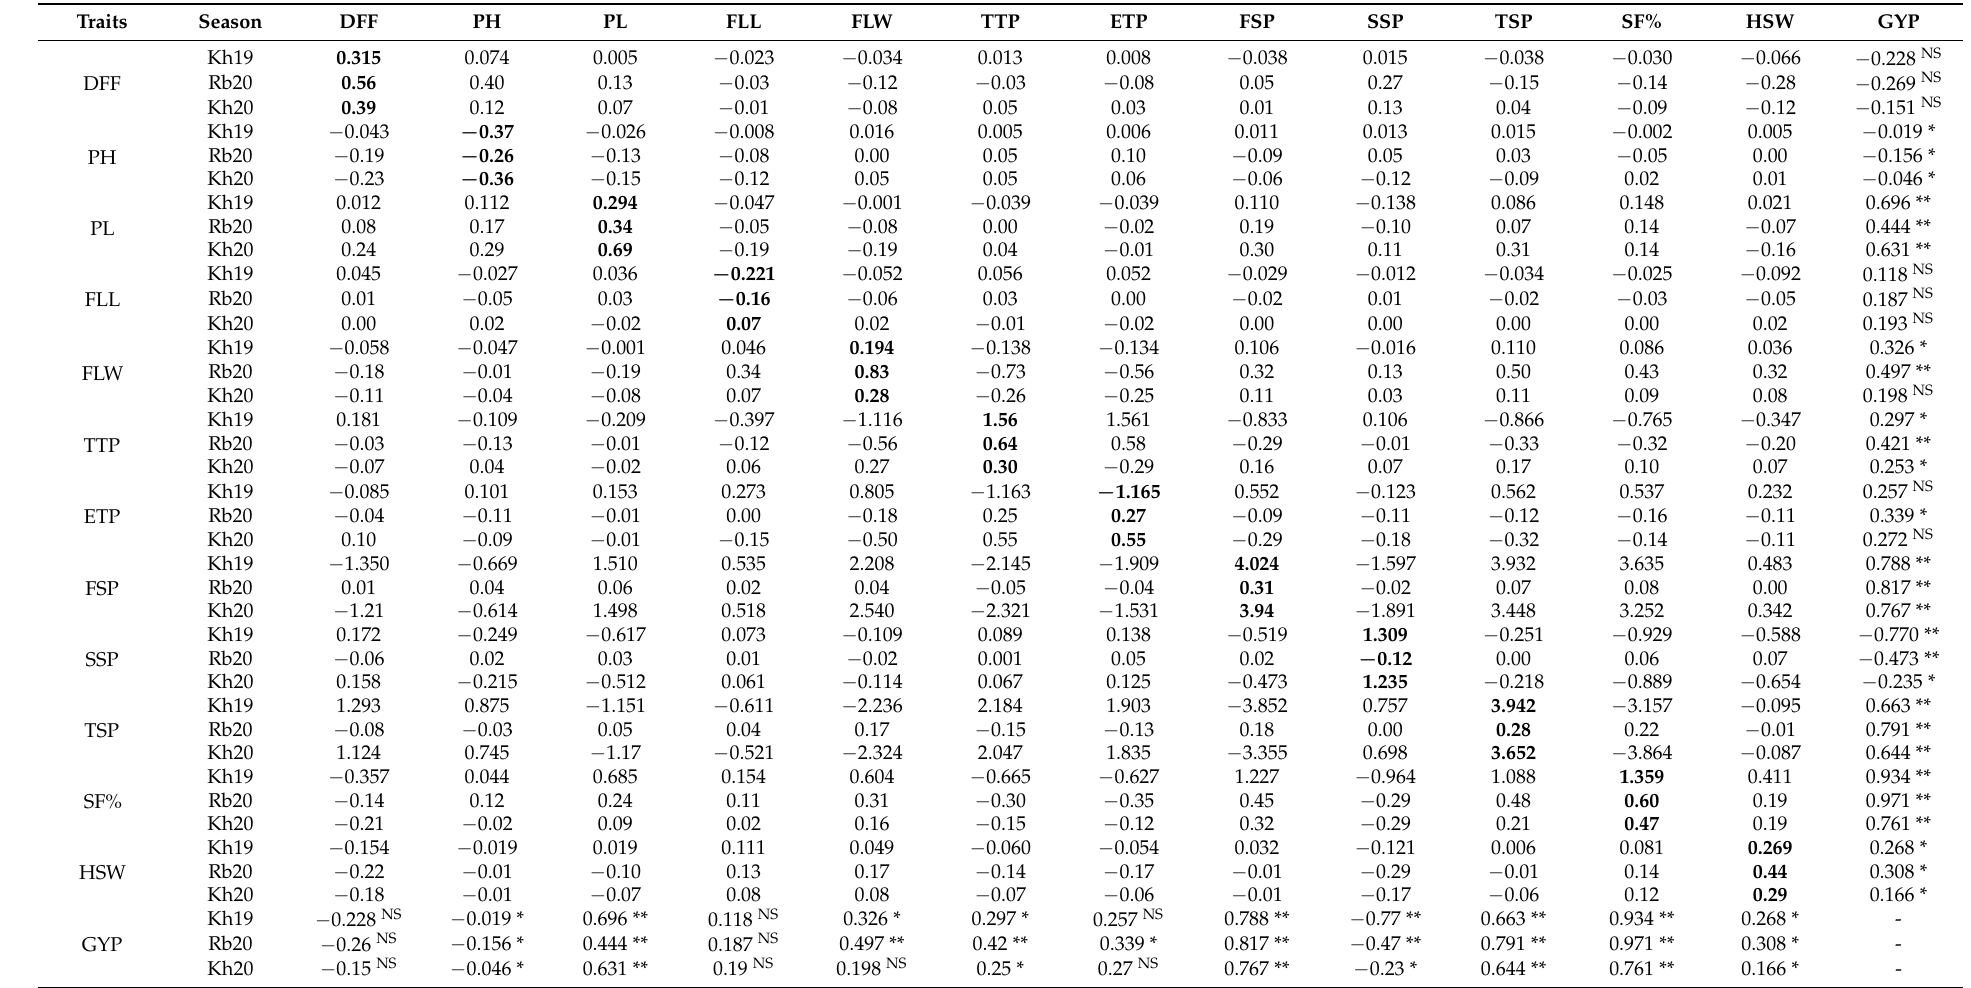
Table 5. Path coefficient analysis for the agro-morphological traits during all three